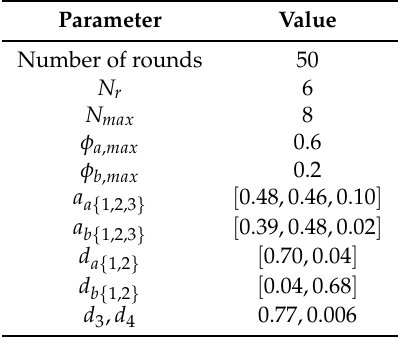
Table 4. Simulation parameters for the repeated game.